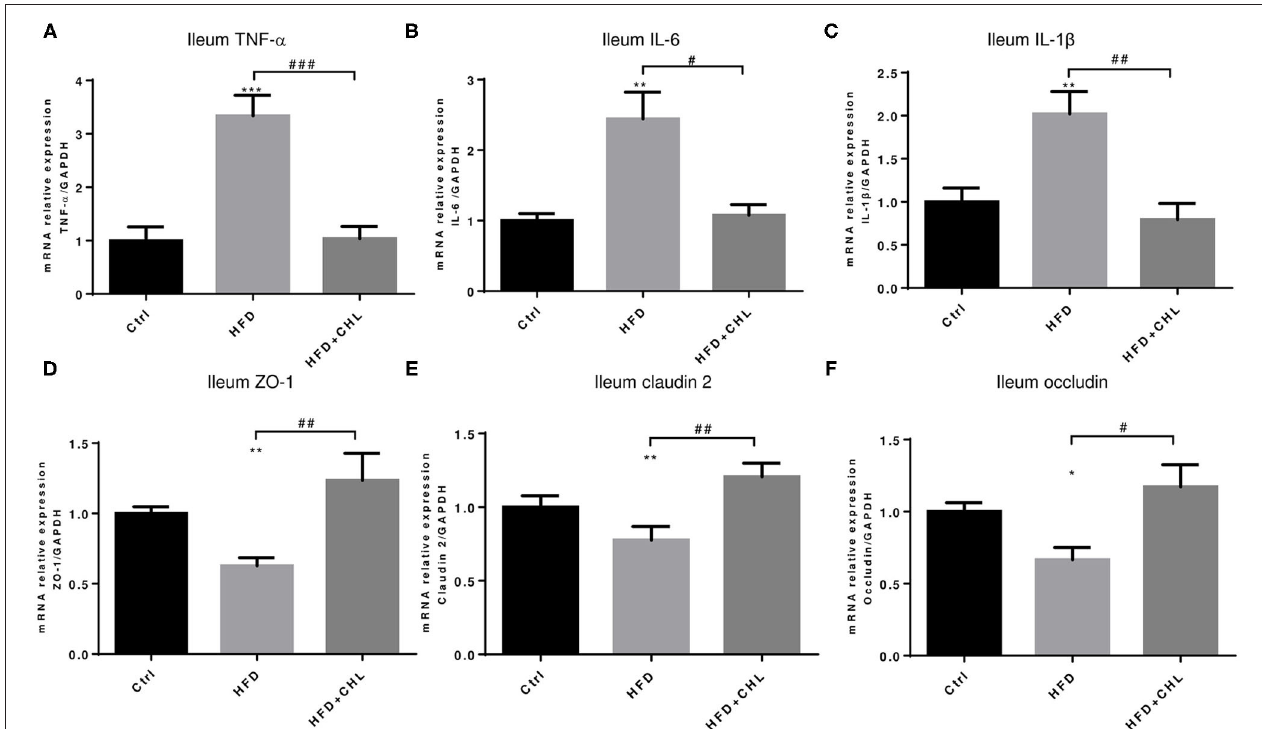
FIGURE 8 | CHL improves small intestinal innate immunity and suppresses intestinal inflammation of the mice fed with an HFD. (A) The experimental condition is described in Figure 1 . The microRNA (mRNA) levels of TNF- α in the ileum were determined by RT-qPCR analysis. (B) The mRNA of interleukin 6 (IL-6) levels of the ileum. (C) The mRNA levels of IL-1b in the ileum. (D) ZO1 expression in the ileum. (E) The mRNA levels of Claudin 2 expression in the ileum. (F) The mRNA levels of occludin expression in the ileum and n = 6–8 for each group. Values are mean ± SEM; * p < 0.05, ** p < 0.01, *** p < 0.001 vs. Ctrl group; # p < 0.05, ## p < 0.01, ### p < 0.001 vs. HFD